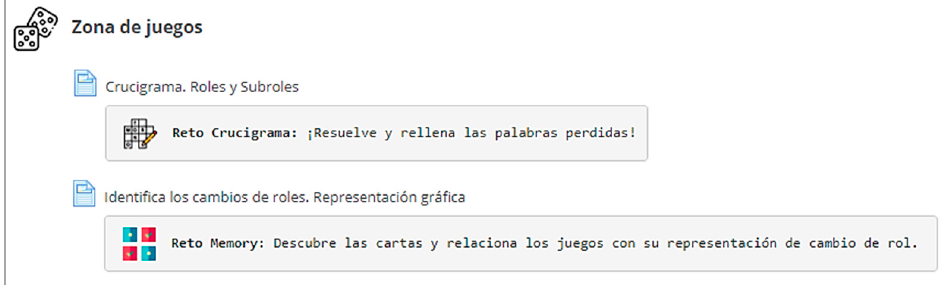
Figure 4. Competitive gamification dynamics with classification. EGc group. At the end of the experience, both groups were tested on their knowledge, and the students in the experimental group were given the CMELAC questionnaire. Finally, they were asked the three open-ended questions specified before. 2.5. Data Analysis Data were initially evaluated through preliminary analyses that included the study of data distribution and missing values. In this regard, no missing data were observed in our study. Then, the data analysis addressed two different, complementary approaches. Firstly, we tested the effect of the intervention on students’ academic performance, comparing the experimental and the control groups. In such analysis, dependent variables were students’ roles and sub-roles academic performance, motor communication aca- demic performance and total performance. This analysis was conducted with a t-test for independent samples, which compares the means of the groups analyzed [77]. As a result of the multiple t-tests performed during our analyses, we undertook a Bonferroni adjust- ment to the alpha level (new p = 0.017). Secondly, we tested for possible differences depending on the type of Gamification experienced. Independent sample t-tests were used again, with the dependent variables being students’ academic performance (i.e., roles, motor communication and total), gam- ification scores (i.e., roles score, motor communication score and total score) and motiva- tion (i.e., task motivation, Motivation to learn and Flow). We also considered a Bonferroni adjustment to the alpha level (new p = 0.006) in those comparisons. All analyses were con- ducted using IBM SPSS Statistics, v. 23. A deductive procedure was used in the analysis of the qualitative data [78] based on the consideration of the questions asked and the subsequent development of the coding [79] (Table 1). However, during the data analysis, the inductive method was also used to expand the list of subcategories. The software ATLAS.ti version 7 was used. Table 1 . Categories and subcategories